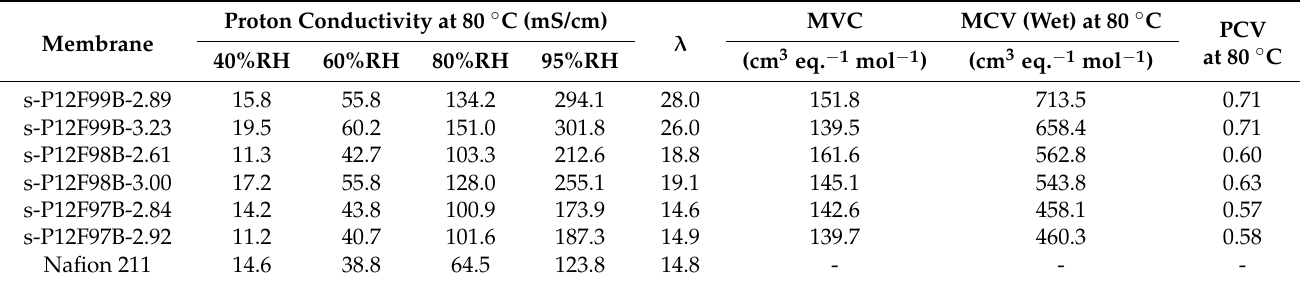
Table 3. Proton conductivity, MVC, and PCV of the s-P12FmB-X membranes at 80 ◦ C. Proton Conductivity at 80 ◦ C Membrane